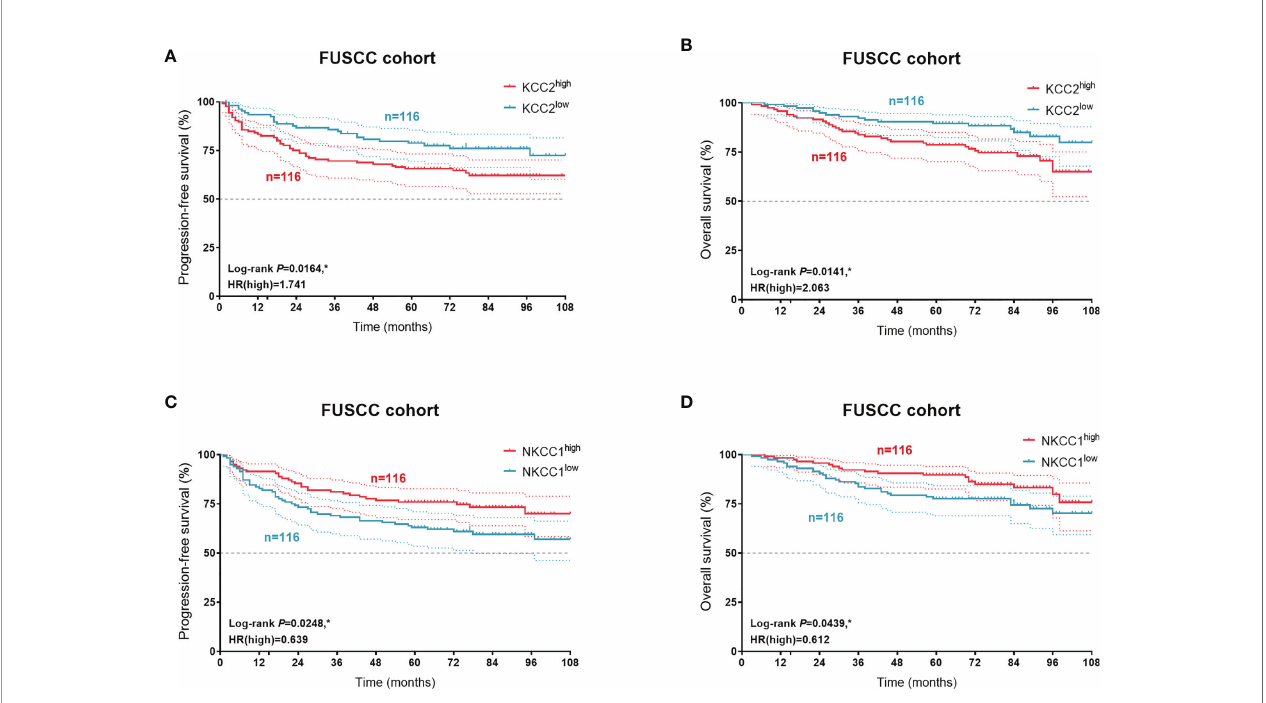
FIGURE 12 | Prognostic validation of KCC2 and NKCC1 expression in 232 KIRC patients from a real-world cohort. In order to verify our hypothesis and predictive implications of KCC2 (A, B) and NKCC1 (C, D) expression, we enrolled 232 patients with follow-up and protein expression data using Kaplan – Meier methods. *p <